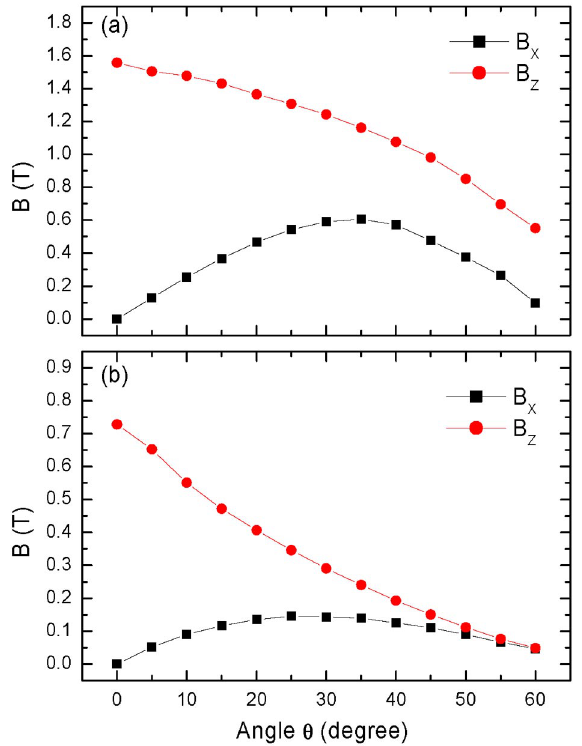
FIG. 5. (Color) Magnetic-flux densities B of rotation angle (cid:6) in (a) the racetrack coil structure and (b) the staggered structure. The period was fixed at 1.5